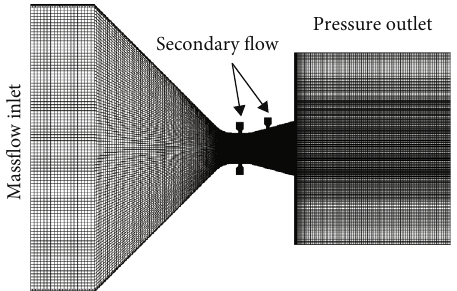
Figure 1: Mesh and boundary condition.